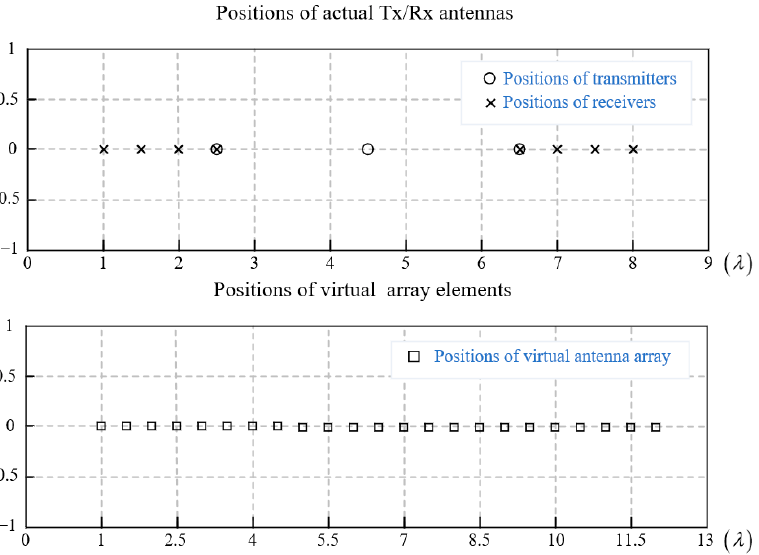
Figure 1. The relationship between the real Tx/Rx antenna positions and the virtual array positions.